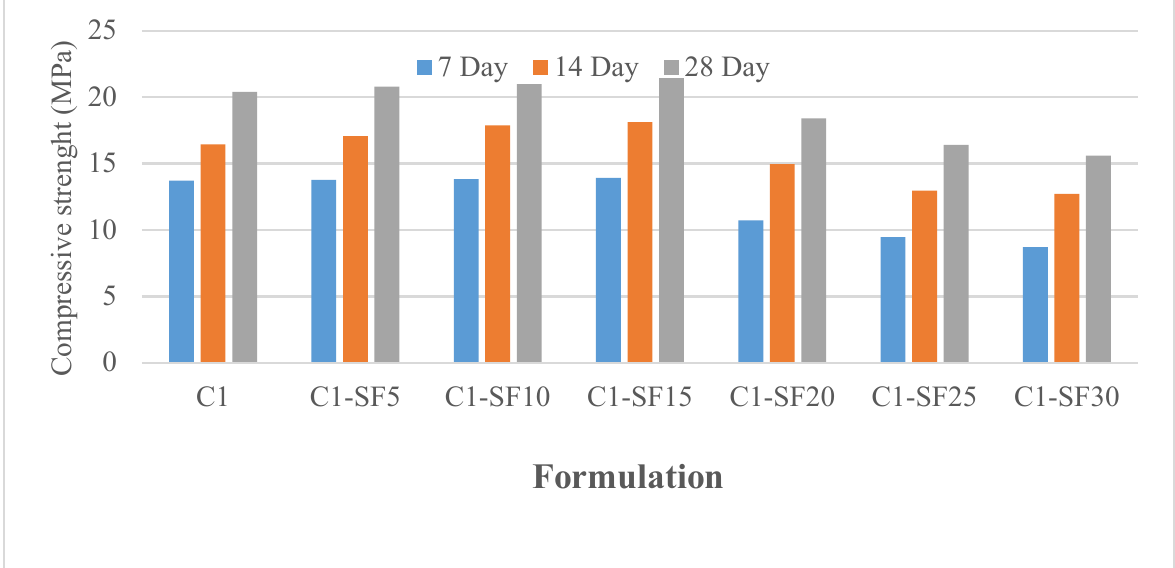
Figure 2. Compressive strength of concrete human hair fiber with Silica fume. 3.1.3. Effect on HHFC Compressive Strength with Replacement of Cement by Silica Fume Using RSM The red zone represents a higher strength region, whereas the green region represents a lower strength region of HHFC strength, as shown in the 2D contour plot in Figure 3b. The red zone has the highest compressive strength value, and the green and blue regions have the lowest compressive strength values. For HHFC and SF, the highest compressive strength was 21.5 MPa at 2% and 15%, respectively. The contours’ slanted appearance showed a weak interaction between the factors (percentages of HHFC and SF). According to the 3D response surface plot in Figure 3a, the compressive strength reduces dramatically as the SF concentration increases